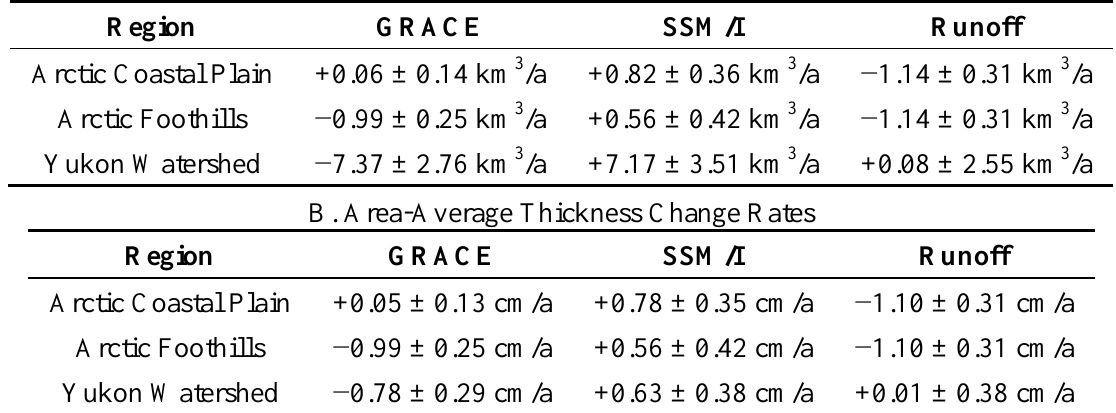
Table 1. Regionalized Gradients of GRACE (water equivalent mass), SSM/I (snow water equivalent) and Runoff Changes from August 2002 through December 2008.